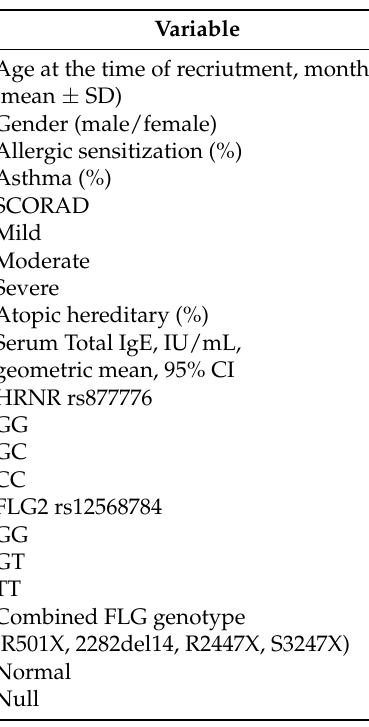
Table 1. Characteristics of the study